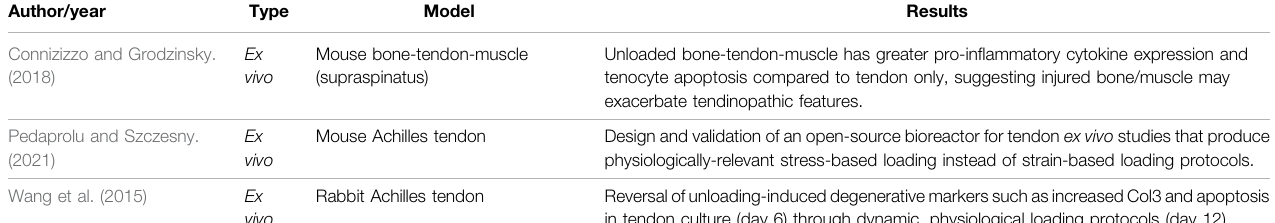
TABLE 1 | Highlighted summaries of recent ex vivo studies with associated loading schemes. Images created with